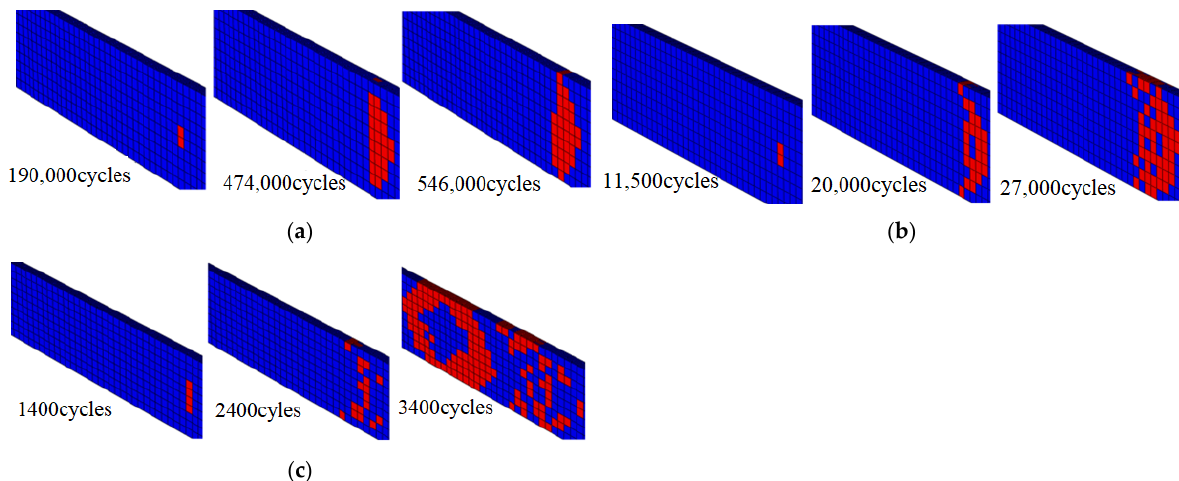
Figure 9. Fatigue failure process calculated by the finite element method. ( a ) RTD; ( b ) CTD; ( c )